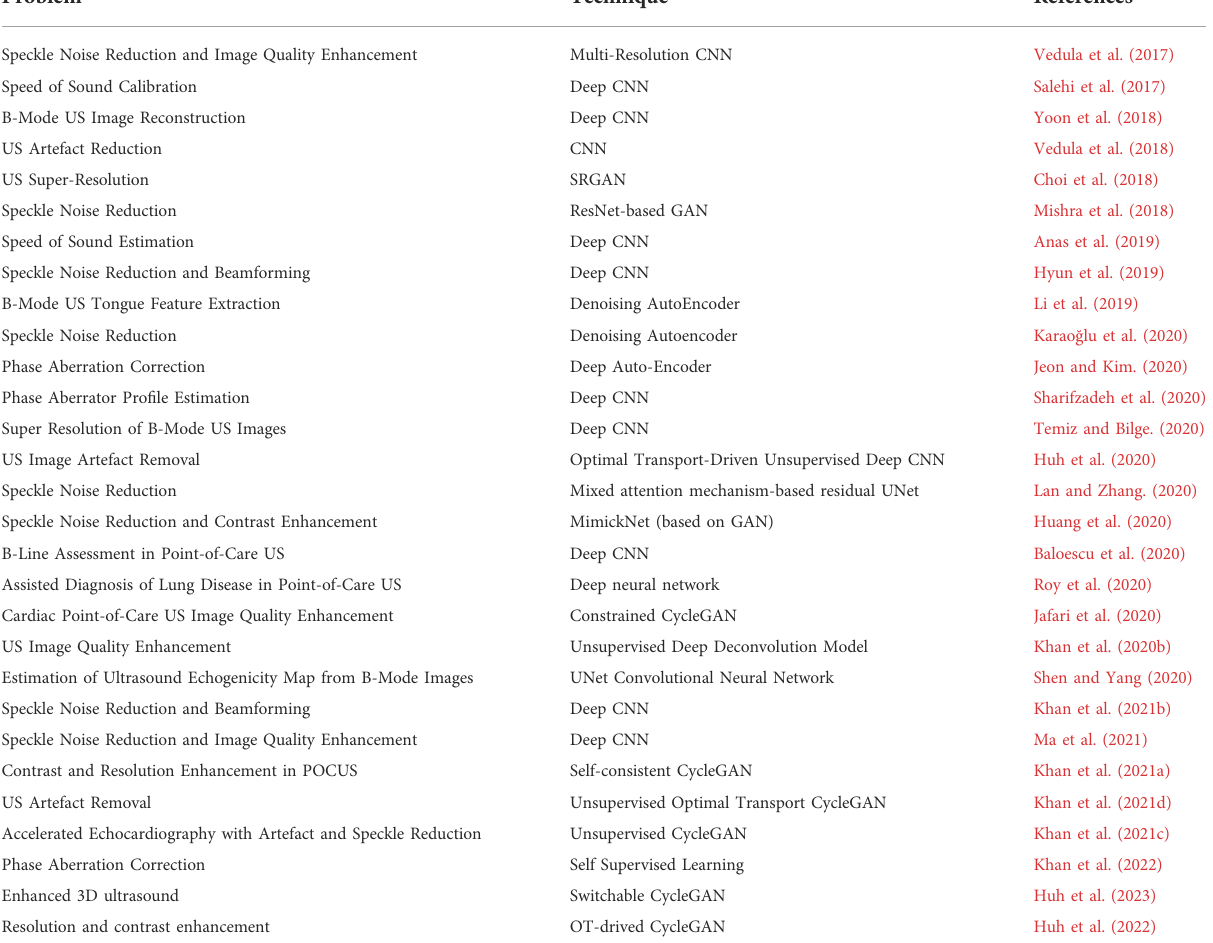
TABLE 1 A short summary of research conducted on deep learning-based US